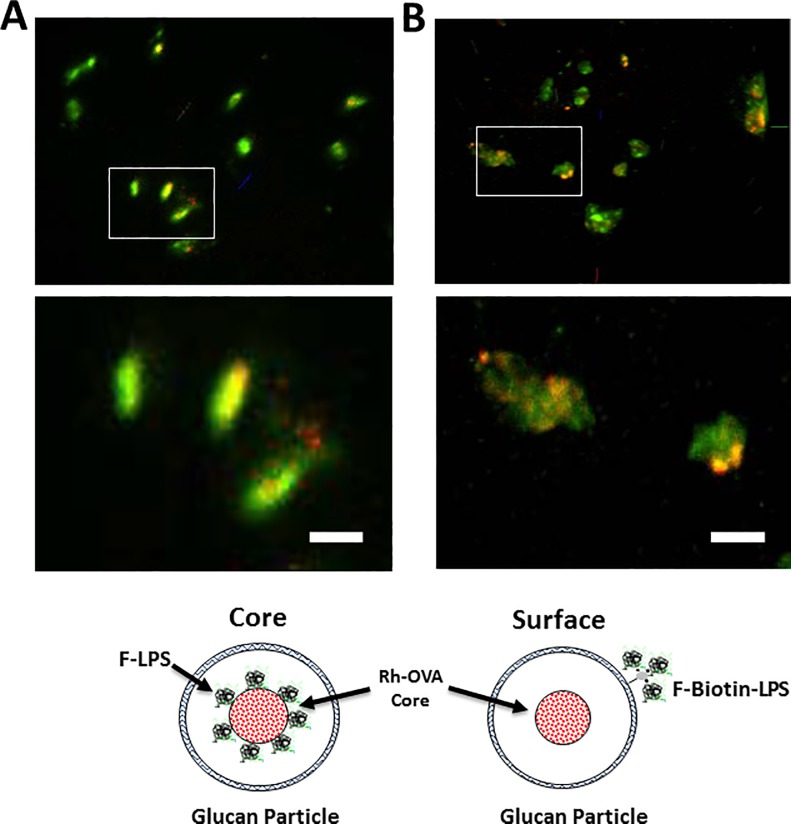
Confocal microscopy distinguishes between GPs containing core loaded or surface linked LPS.Panel A shows images of GPs core co-loaded with both Dylight 633-labelled OVA (red) or DTAF-labelled Francisella LPS (green) antigens. Panel B shows biotinylated GPs core loaded with Dylight 633 OVA and then surface bound to biotinylated DTAF-LPS via a streptavidin linker as also shown graphically with the cartoon. The punctate yeast shell bound F-LPS appears slightly larger than the internally loaded LPS-OVA cores. Size marker on magnified lower images = 1 μm.